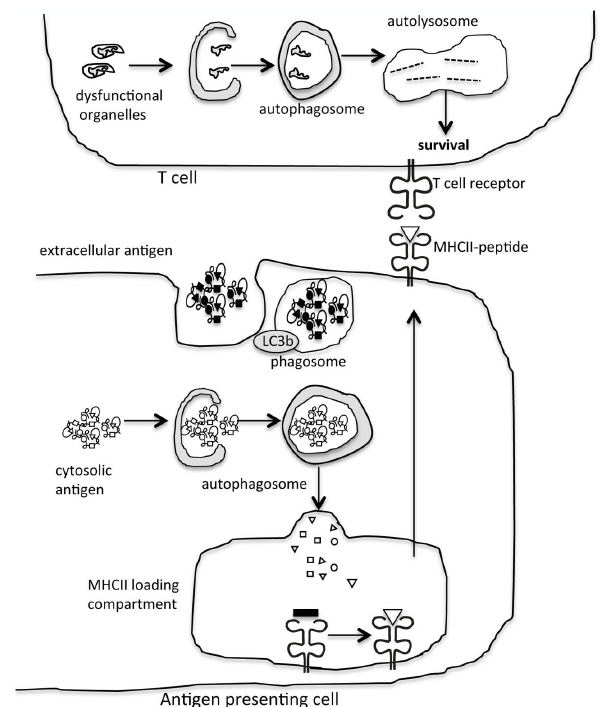
FIGURE 2 |Autophagy modulation of adaptive immunity. Autophagy is a significant trafficking pathway for the delivery of cytosolic antigen to the MHCII loading compartment in antigen presenting cells. In addition, proteins in the autophagy machinery contribute to phagocytosis of extracellular antigen. In lymphocytes, the role of autophagy in eliminating damaged organelles promotes cell survival. Rapamycin administration in vivo , inhibits the detected increase in IL-1 β but not IL-12, in the serum 4 h following lipopolysaccha- ride (LPS) treatment (Harris et al., 2011). Not all stimuli